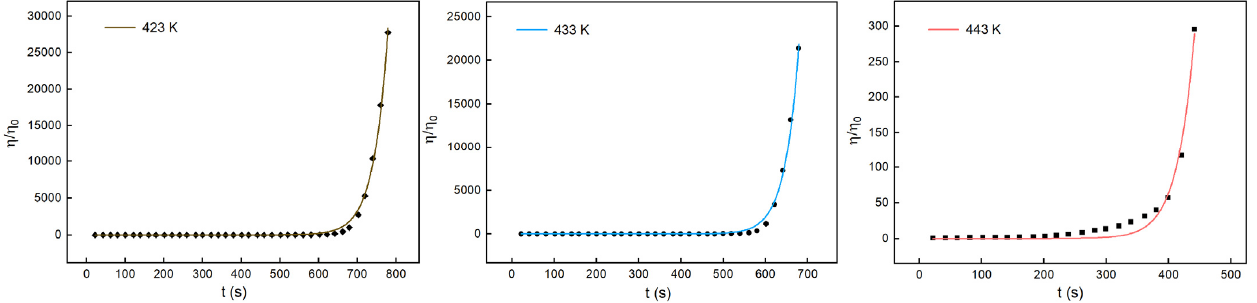
Figure 17. The fitting line for the η 0 of the H 6 XDI/BES system.